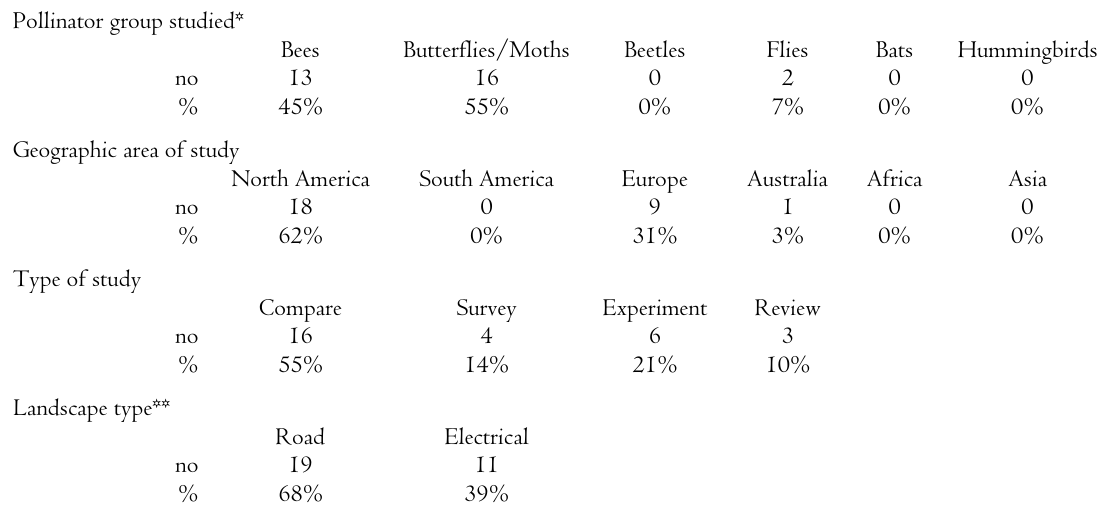
Table 3: Summary statistics for literature reviewed Pollinator group